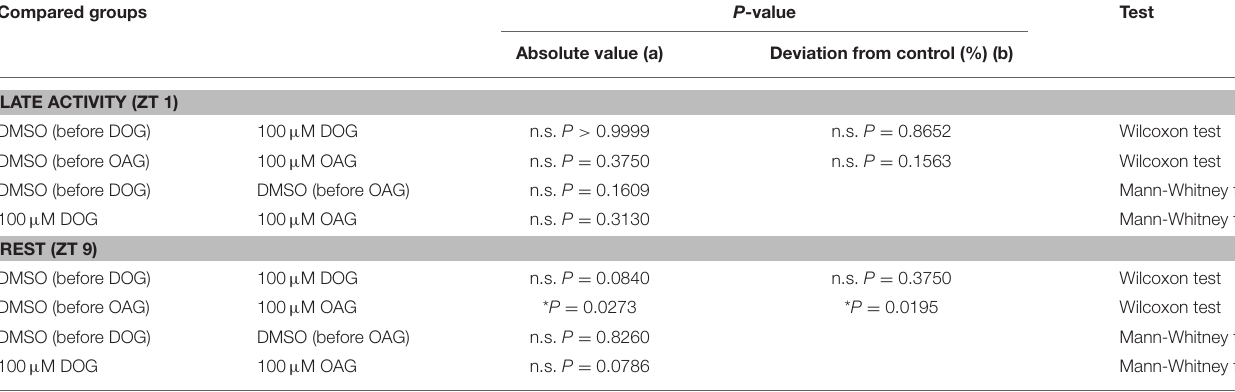
TABLE 6 | Statistical analysis of the spontaneous activity in the presence or absence of 100 µ M DOG or OAG during the late activity phase and at rest ( Figure 9 ). Compared groups P -value Test Absolute value